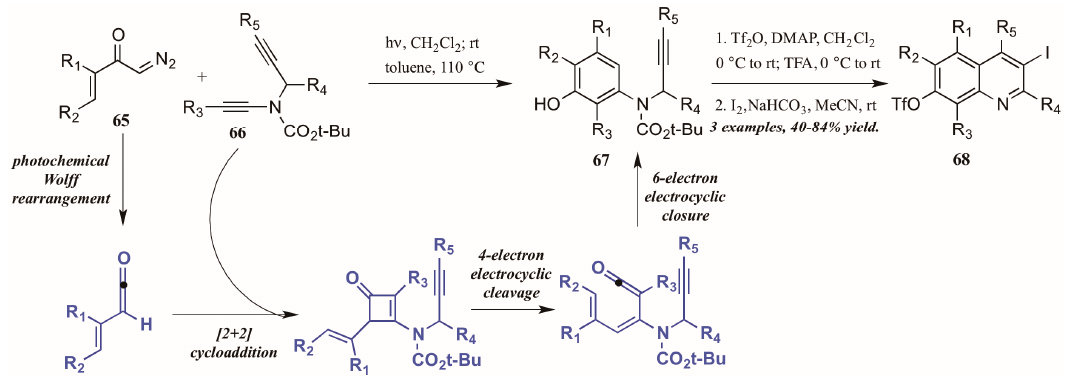
Figure 30. Photochemical electrophilic cyclization to form highly functionalized quinolines.